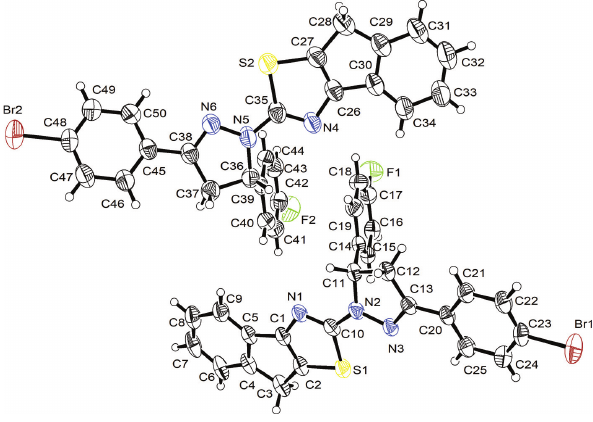
figure. Table 1 contains crystallographic data and Table 2 con- tains the list of the atoms including atomic coordinates and displacement parameters.